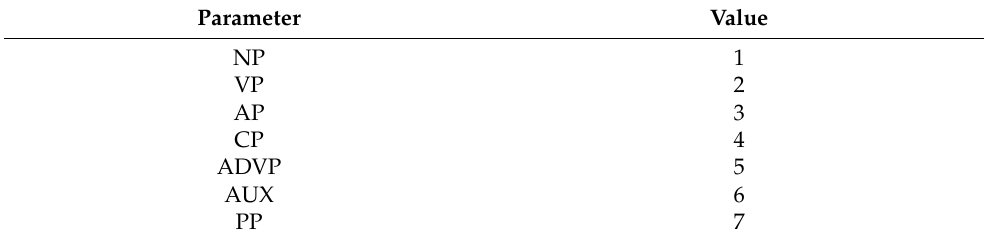
Table 1. Syntactic categories.